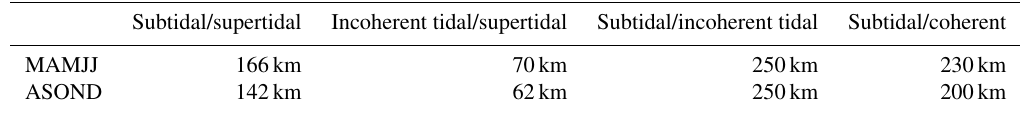
Figure 13. SSH meridional wavenumber spectra separated into different frequency bands during (a, c) MAMJJ and (b, d) ASOND. (a, b) SSH1 (hourly residual between the total SSH and the coherent barotropic SSH, over all frequencies (full; blue), subtidal ( f < 1 / 28h − 1 ); red), tidal (1 / 28h − 1 f < 1 / 11h − 1 ; green) and supertidal frequencies ( f > 1 / 11h − 1 ; cyan). Saral_full (in black) is the mean of SARAL/AltiKa along-track SSH spectra for the period 2013–2014, and NTSSH (orange) is the hourly SSH of the model with no tides. (c, d) Hourly coherent baroclinic SSH (SSHBC_full, purple) and SSH2 (hourly incoherent baroclinic SSH) at tidal (brown) and supertidal (pink) frequency bands. All spectra are evaluated within 0–10 ◦ N, 43–45 ◦ W and averaged over the longitudes. The vertical dotted green line delimits the classical 250–70km mesoscale band. Units are in cm − 2 cpkm − 1 . Table 3. Transition length scale between balanced and unbalanced motion.